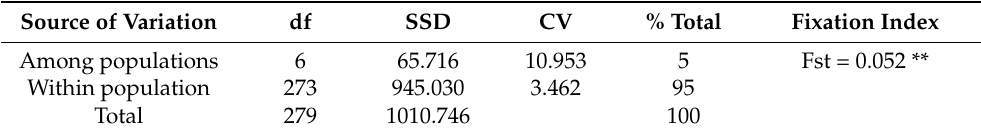
Table 4. Summary of molecular variance (AMOVA) from EST-SSR loci data collected of the matrix of genetic distances of 280 genotypes from 7 populations of Gevuina avellana Mol. Source of Variation df SSD CV % Total Fixation Index Among populations